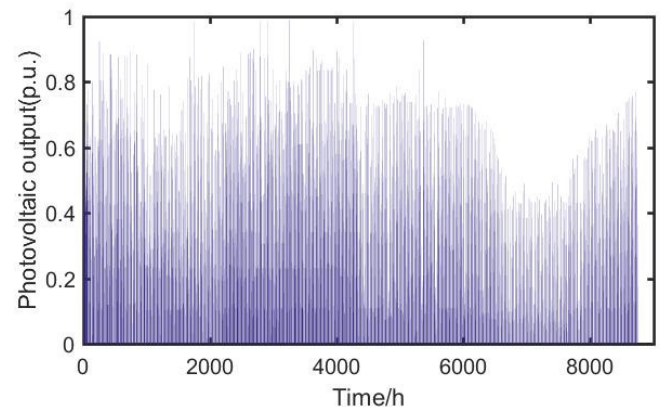
Figure 3. Annual fluctuation of Photovoltaic output.